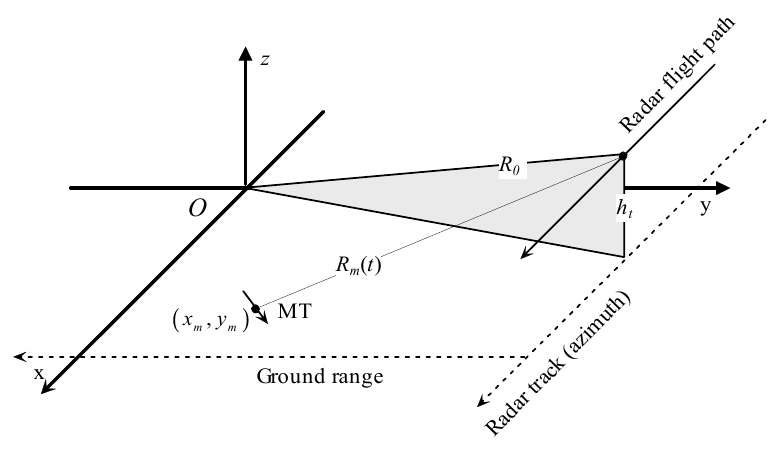
Figure 1. SAR data collection geometry.